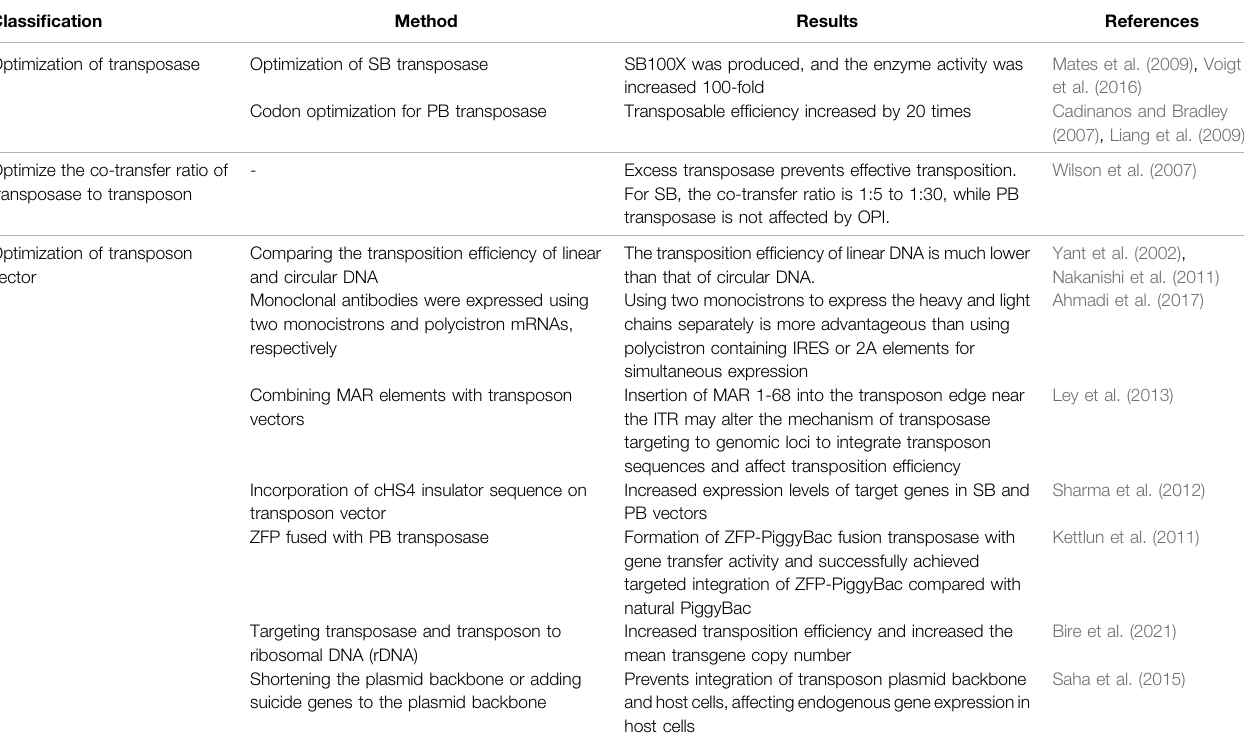
TABLE 1 | Optimization of transposon